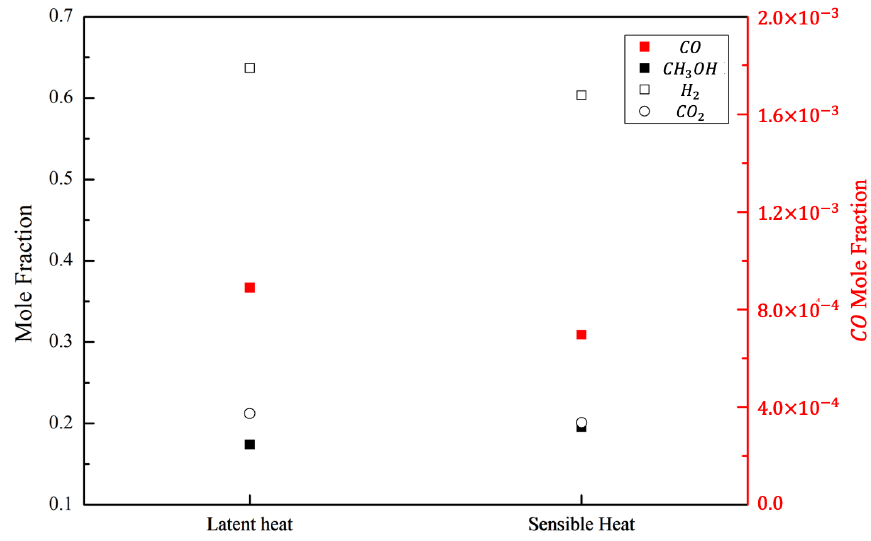
Figure 6. Outlet mole fractions on a dry basis according to the type of heat source.